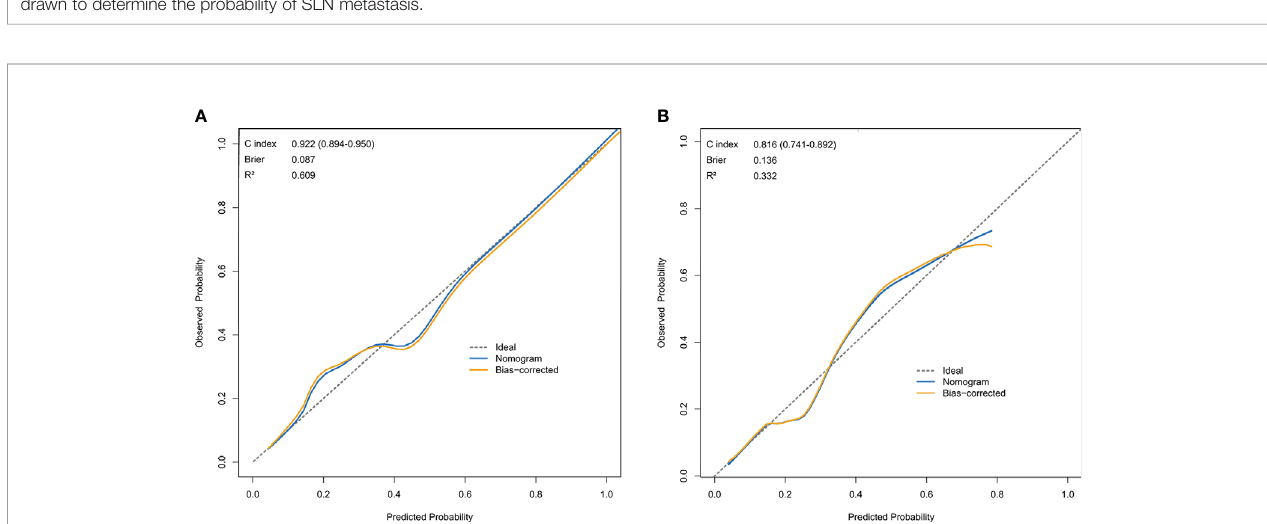
FIGURE 2 | Nomogram to predict the rate of SLN metastasis in clinically LN-negative breast cancer patients. The nomogram to predict SLN-metastasis-risk was created based on the above seven predictive factors. To use the nomogram, the value of each patient is placed on each variable axis and a line is drawn upward to determine the number of received points for each variable value. The sum of these numbers is located on the total point axis and a line down the bottom axis is drawn to determine the probability of SLN metastasis.